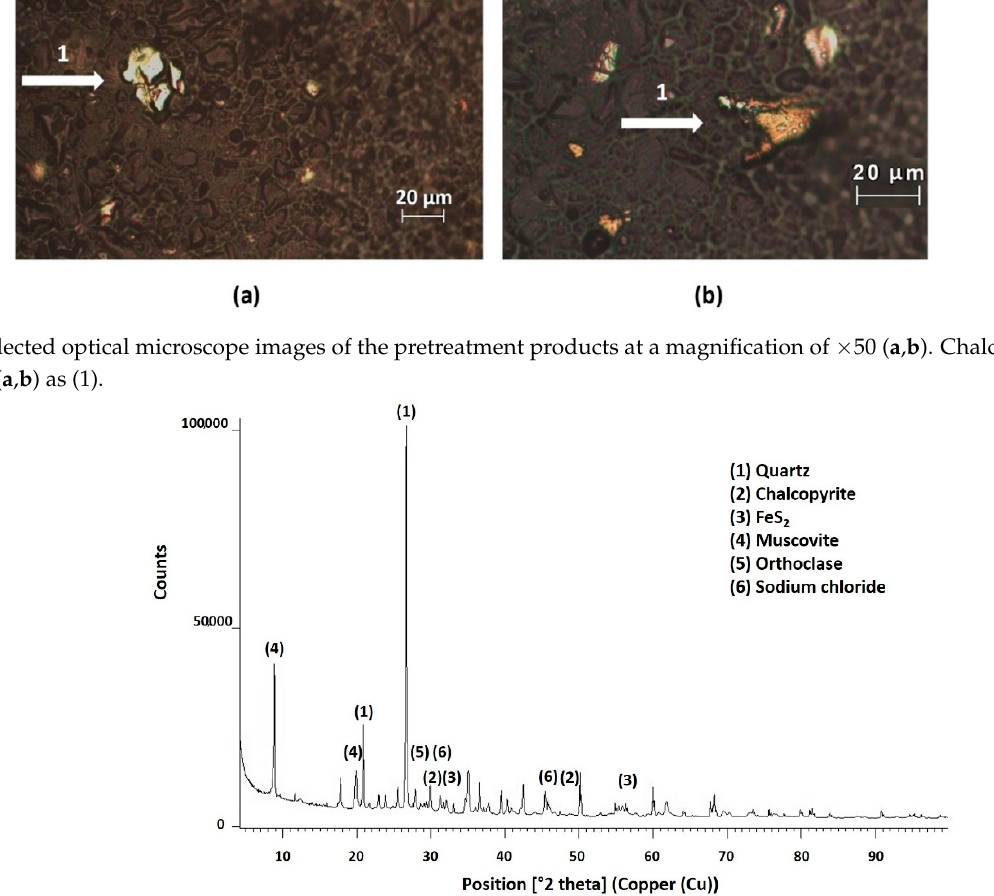
Figure 6. X-ray diffractogram for copper sulphide ore agglomerated with 15 kg/t of H 2 SO 4 , 25 kg/t of NaCl, and 15 days of curing time at room temperature.